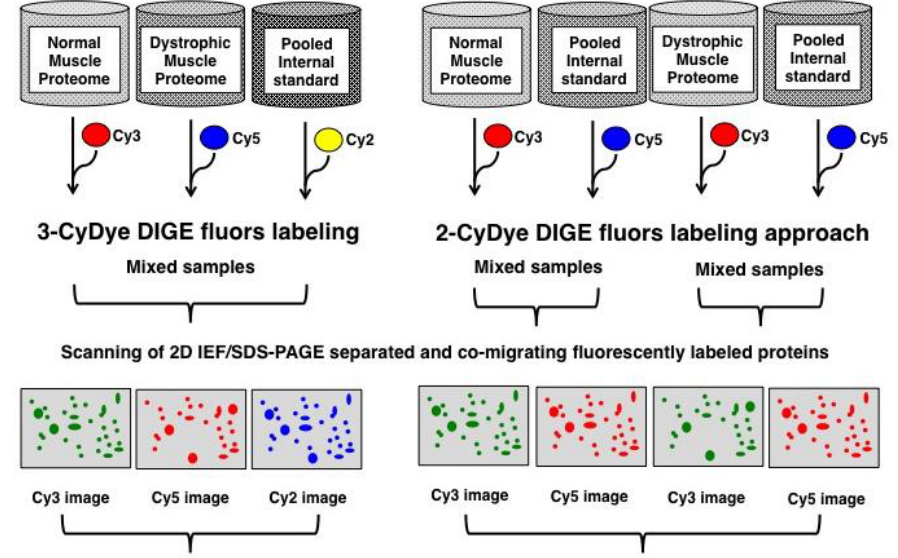
Figure 1. Overview of the fluorescence difference in-gel electrophoresis method: Shown are the main approaches used in fluorescence gel-based proteomics, whereby 2-dye or 3-dye difference in-gel electrophoresis (DIGE) is most commonly applied for studying global changes in complex protein populations. In the case of muscular dystrophy research, normal and dystrophic specimens are differentially labeled with CyDyes prior to electrophoresis, then proteins separated based on the unique combination of their isoeletric point and molecular masses and finally image analysis used to evaluate differential expression pattern of fluorescently labeled